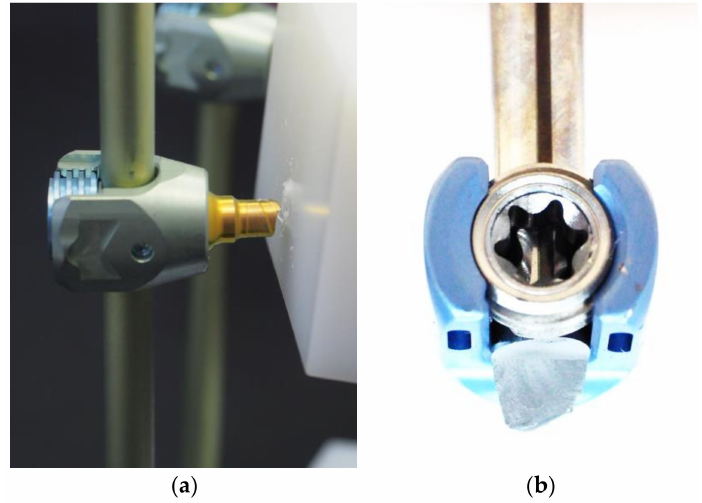
Figure 4. Failure patterns from the dynamic compression bending test in ( a ) Group A and ( b ) Group